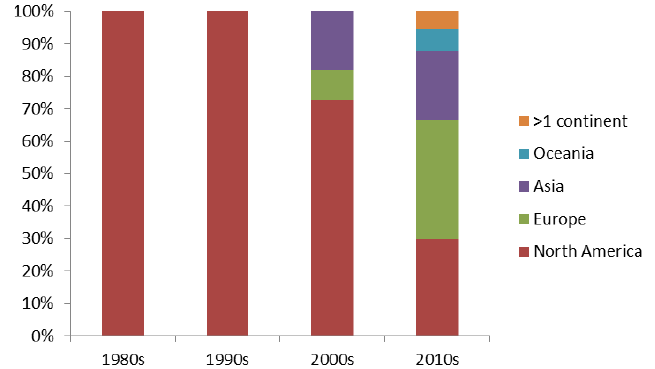
Figure 2. Choice Modelling (CM) studies per continent.